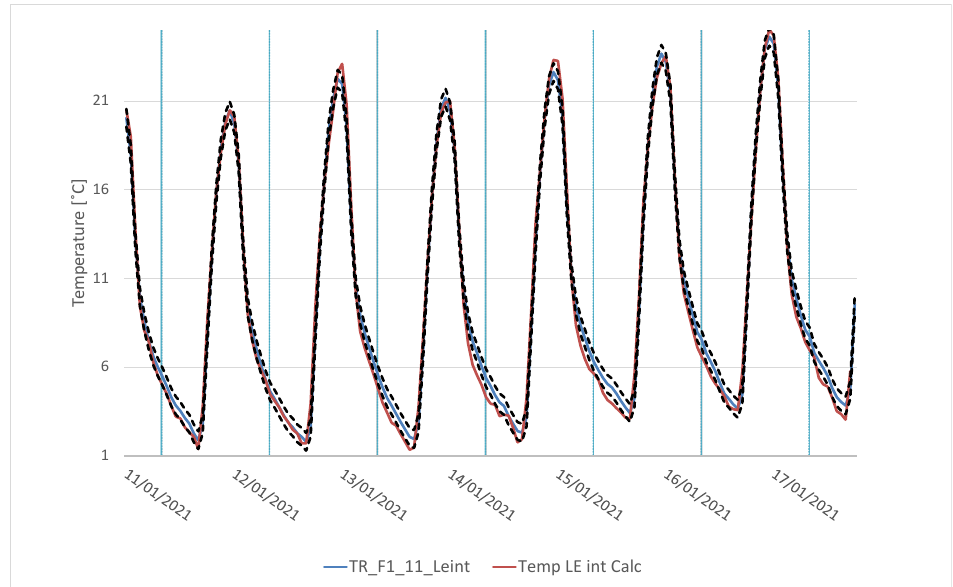
Figure 20. Cell 1. Winter. Grid open. Temperatures of the interior face of the outer slab in Zone 4: measured ( ) and calculated ( ). Bands of ± 0.5 ◦ C, ( ), are